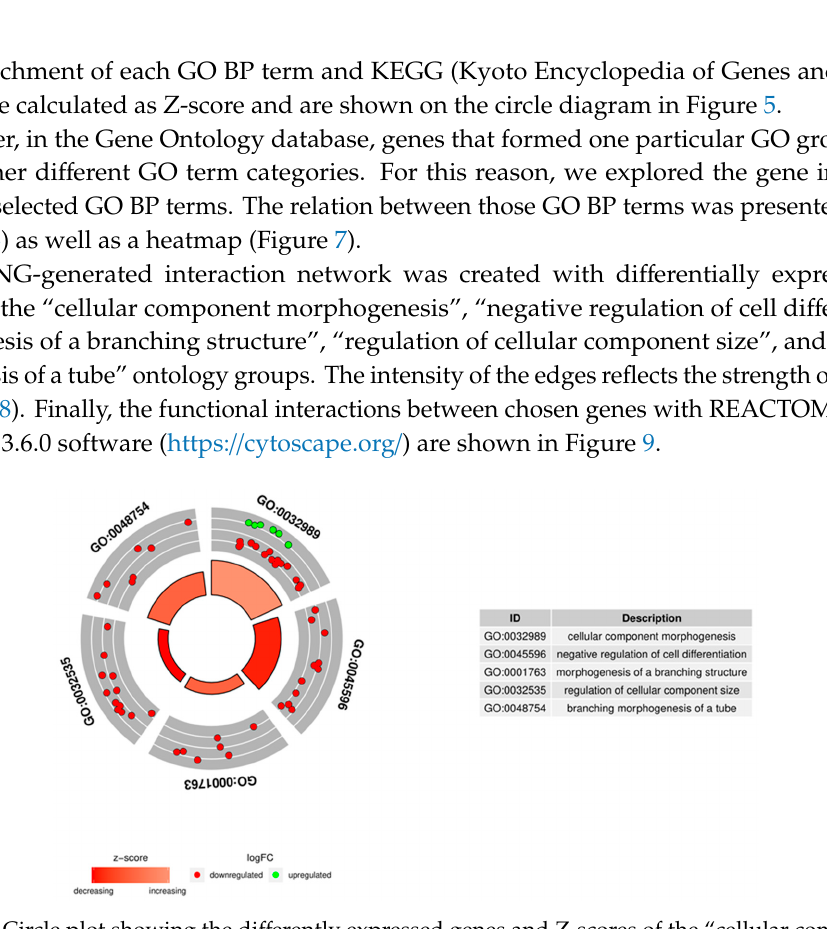
Figure 5. Circle plot showing the di ff erently expressed genes and Z-scores of the “cellular component morphogenesis”, “negative regulation of cell di ff erentiation”, “morphogenesis of a branching structure”, “regulation of cellular component size”, and “branching morphogenesis of a tube” Gene Ontology Biological Process (GO BP) terms. The outer circle shows a scatter plot for each term of the fold change of the assigned genes. Green circles represent upregulation and red ones represent downregulation. The inner circle shows the Z-score of each GO BP term. The width of each bar corresponds to the number of genes within GO BP term and the color corresponds to the Z-score. Table2. Genesymbols, ratiooffoldchangeinexpression, corrected p values, andLogFCofstudiedgenes. Gene Gene ID Fold Change p